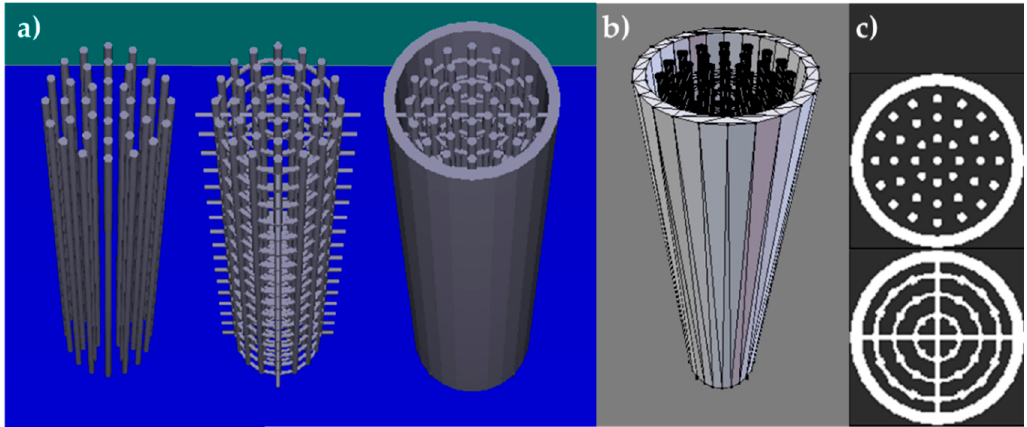
Figure 3. ( a ) Stages of designing 3D digital model (from left); ( b ) tessellated model; ( c ) slices (layers) into which the model is split.